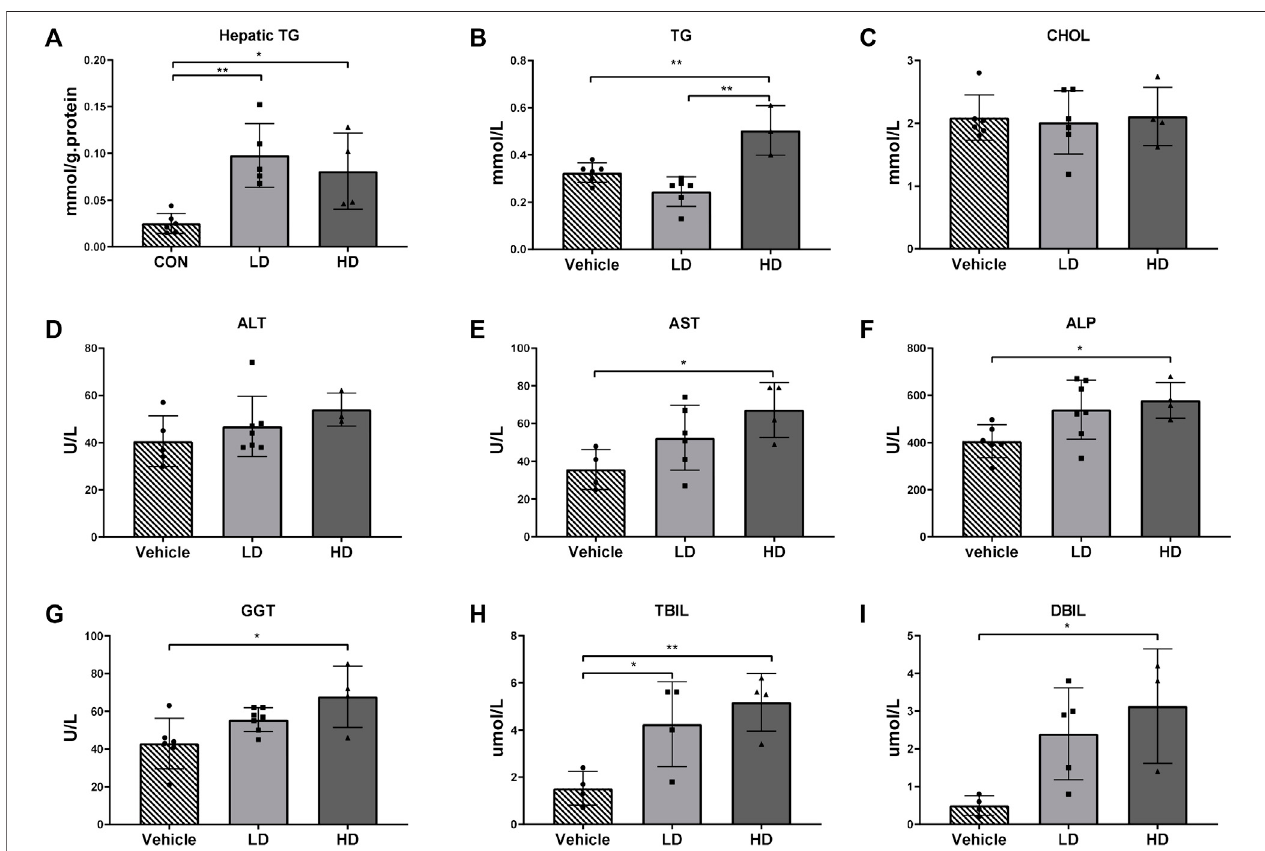
FIGURE 4 | TM-induced ERS impairs liver function in piglets. Piglets were administered with TM LD (0.1 mg/kg body weight), HD (0.3 mg/kg body weight), or vehiclefor 48 h. (A) Hepatic TGlevels in differentgroups. (B – I) Plasma level of TG, CHOL, ALT, AST, ALP, GGT, TBIL, and DBIL indifferent groups. * means p < 0.05; ** means p <